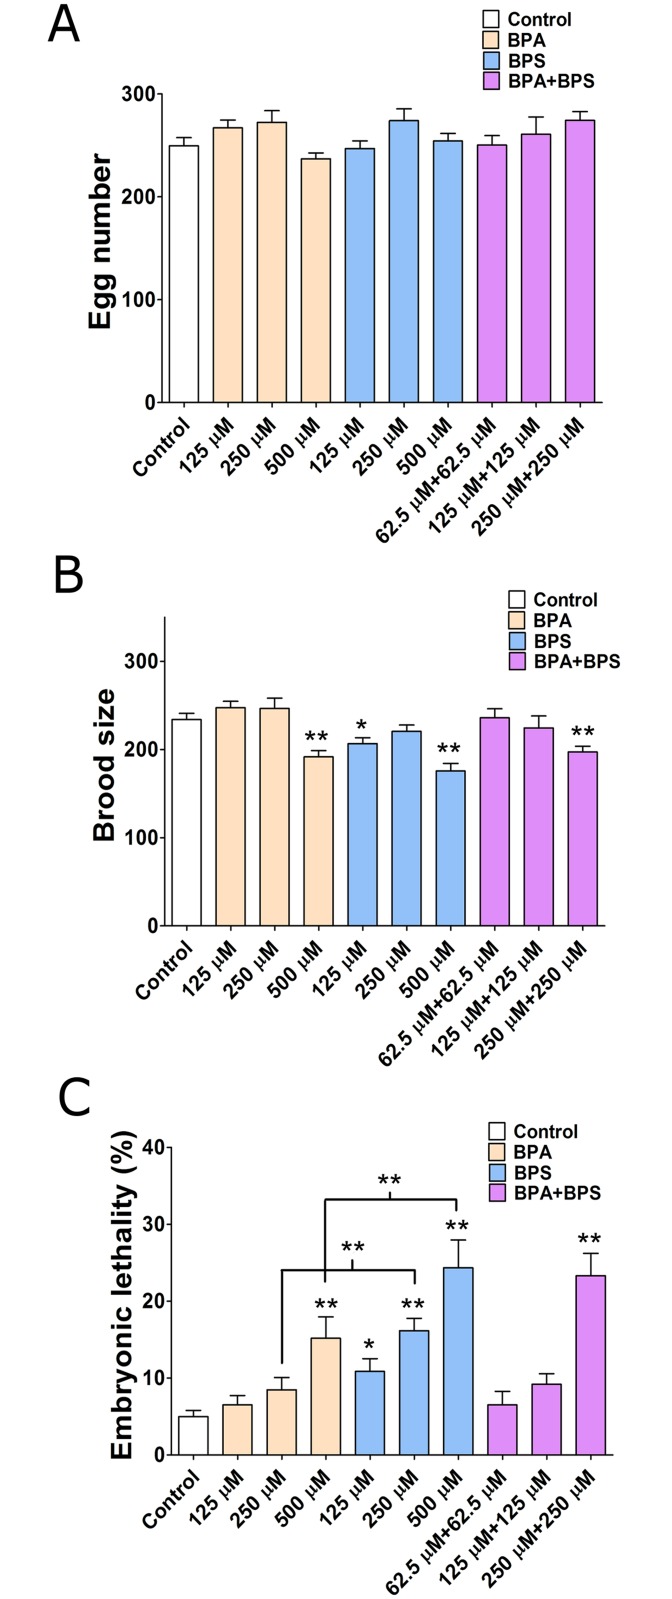
Bisphenols exposure results in sterility, reduced brood size and increased embryonic lethality in C. elegans.Reproductive response to treatment with either vehicle (0.1% ethanol) or indicated doses of BPA and/or BPS. (A) Average number of eggs laid by singled hermaphrodites in each treatment group. (B) Average number of adult progeny (brood size) from singled hermaphrodites in each treatment group. (C) Embryonic lethality observed among the progeny of hermaphrodites in each treatment group. N = 3–4 worms per trial, three repeats per treatment group. All tests are based on t statistics, calculated at each exposure concentration level. *P<0.05, **P≤0.01.